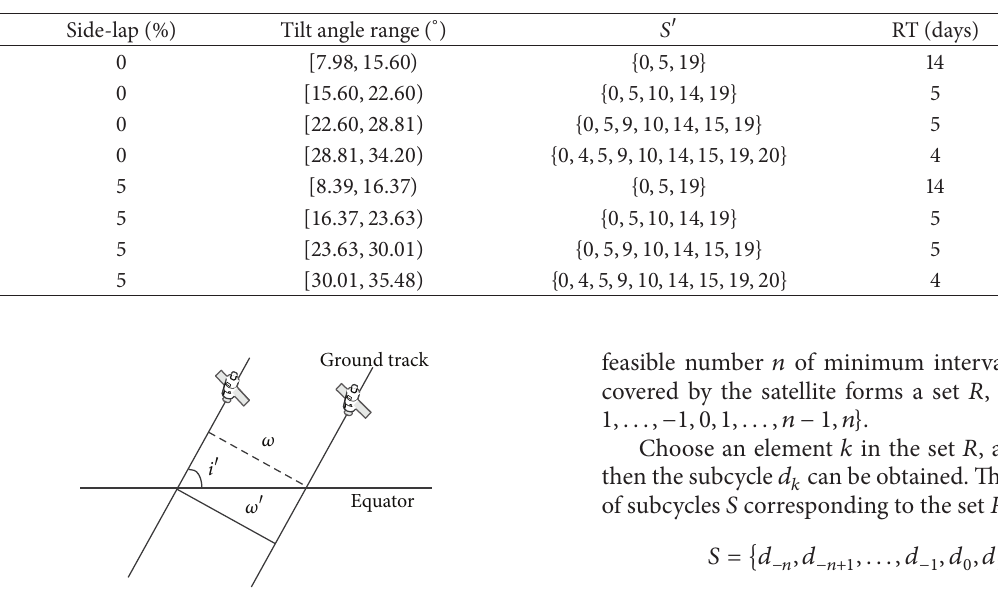
Table 3: Different revisit time of P6 satellite with different tilt capacity and side-lap.